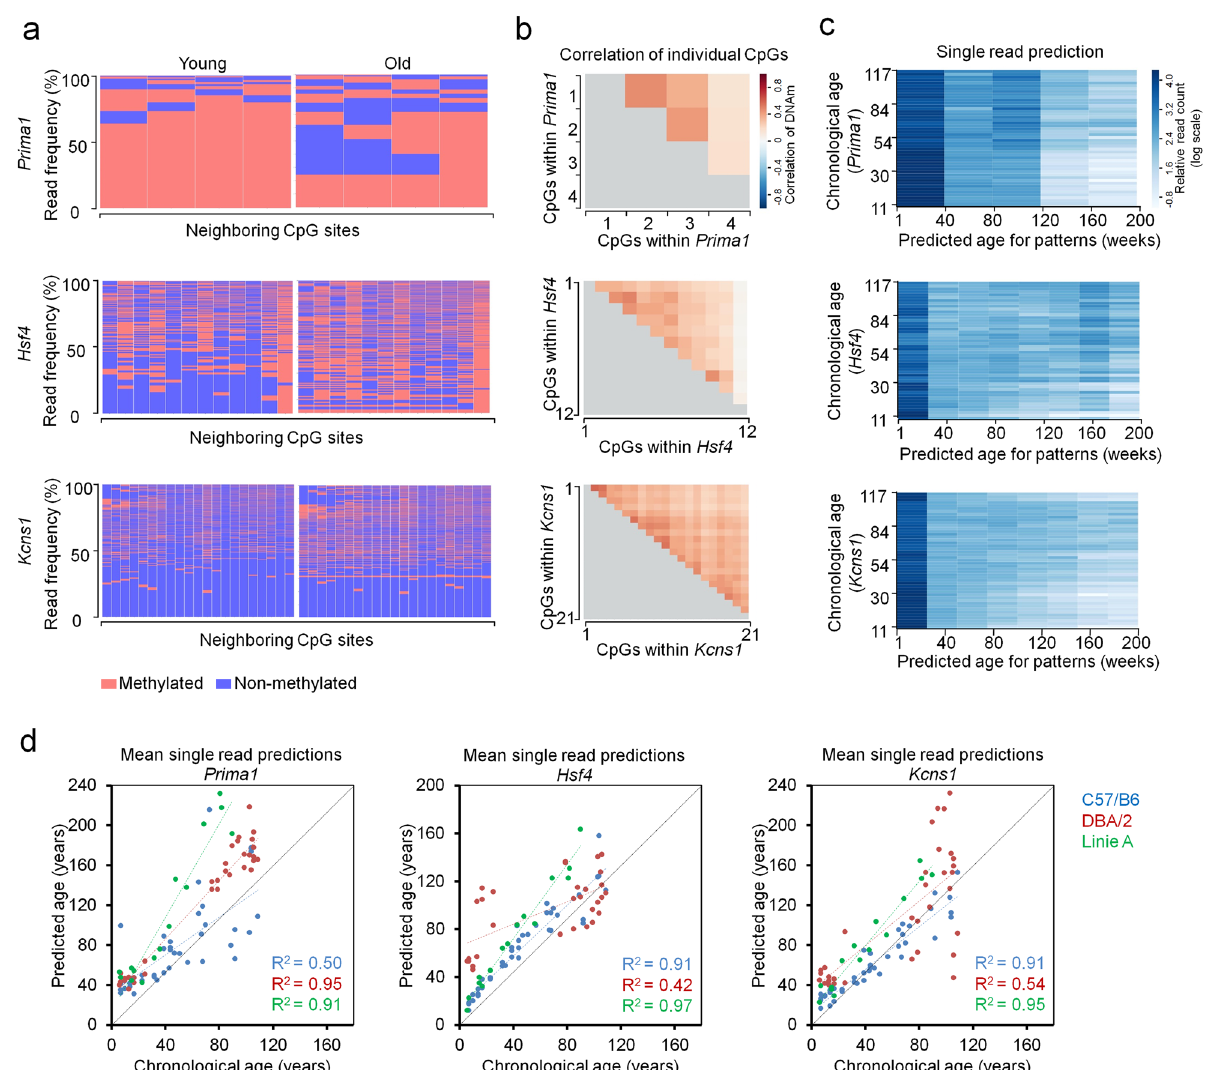
one young (7 weeks) and one old DBA/2 mouse(109 weeks). The frequencies of patterns within the amplicons of Prima1 , Hsf4 and Kcns1 were compared, in analogy to Fig. 4a. ( b ) Pearson correlation of DNAm among neighboring CpGs within three amplicons from DBA/2 mice (n = 33). ( c ) Heatmaps of epigenetic age- predictions for individual BBA-seq reads of DBA/2 mice (n = 33). Epigenetic ages were estimated based on the binary sequel of methylated and non-methylated CpGs for three amplicons (read counts were normalized by the read counts per sample and are depicted in log scale). In analogy to Fig. 4c, each read was classified to predicted ages between 0 and 200 weeks. ( d ) The mean of the single read predictions of BBA-seq data was determined for each sample and then plotted against the chronological age of the DBA/2 (n = 33) and line A (n = 15) mice DNAm versus chronological age are